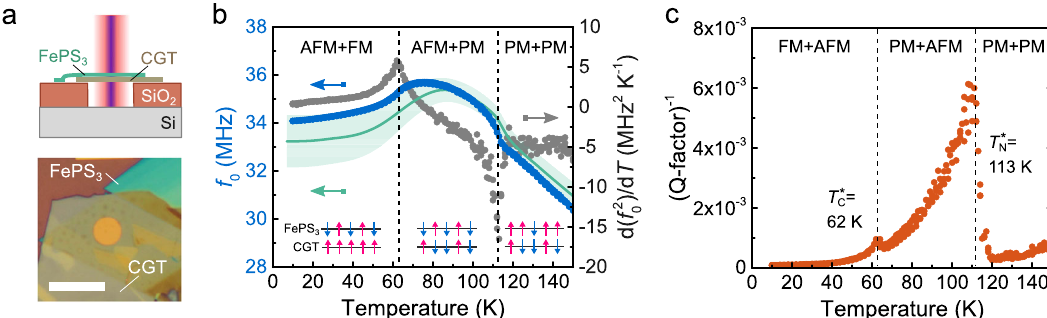
Fig. 4 Mechanical properties of a CGT/FePS 3 (19.8 ± 0.2 nm/18.0 ± 0.1 nm) heterostructure membrane with a radius r = 2.5 μ m. a Top panel: A schematic cross-section of the suspended heterostructure membrane. Bottom panel: The optical image of the sample with the CGT/ FePS 3 heterostructure. Scale bar: 10 μ m. b Filled blue circles — the measured resonance frequency as a function of temperature. Filled grey . Solid green line — the heterostructure resonance frequency model as described by Eq. (4). The light circles — the temperature derivative of f 2 0 ð T Þ . The insets: green region indicates the higher and lower boundary of the model allowed due to the uncertainties in h 1,2 , E CGT and f 2 0 0 Schematic pictures of a magnetic spin con fi guration in FePS 3 and CGT layers in corresponding combinations of antiferromagnetic (AFM), ferromagnetic (FM), and paramagnetic (PM) phases. c The dissipation factor Q − 1 as a function temperature, in which the fi lled orange circles represent the measured data of the CGT/FePS 3 heterostructure. The black vertical dashed lines in ( b ) and ( c ) represent the measured d f 2 0 ð Þ ¼ 62±1 K of CGT and T (cid:3) ¼ 113±1 K of FePS T (cid:3) in ( b 3 as determined from positions of extrema in C N d T ( fi lled blue circles). This behaviour is distinct from the bare CGT resonator (Fig. 2c) due to the positive thermal expansion coef fi cient of the WSe 2 layer, which maintains a tensile total strain of the heterostructure and produces corresponding smaller ð T Þ near T tuning range of f 0 ; CGT = WSe C . 2 We also plot the mechanical dissipation, the inverse of a quality factor Q − 1 ( T ), of both the WSe 2 and CGT/WSe 2 resonators in ð T Þ is visible at T = 58 K. We Fig. 3c. A notable peak in Q CGT = WSe 2 attribute this observation to an increase of the thermoelastic damping 46,47 expected near T C in magnetic resonators 27 . This ð Þ 2 0 ( fi lled observation is supported by the measured maximum in d f d T blue circles) 27 at 58 ± 0.5 K, the temperature which we de fi ne as T (cid:3) C and indicated by the black vertical dashed lines in Fig. 3d. The observed maximum at T (cid:3) relates to the peak in the thermal C expansion coef fi cient of CGT at T C ( fi lled magenta circles) that is shifted to lower temperatures in comparison to its bulk values of 60 – 66 K 2,5 .